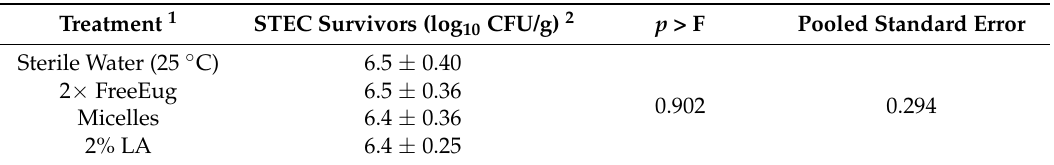
Table 2. Survival of Shiga toxin-producing Escherichia coli (STEC) on fresh beef trimmings following application of antimicrobial